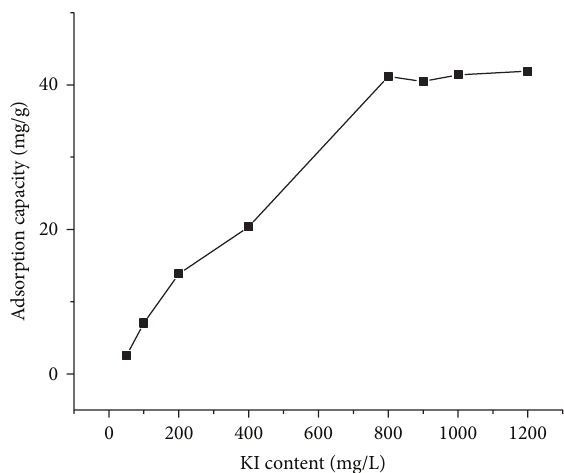
Figure 10: Iodide adsorption capacity of Cu–Mg–Al LDH material as a function of initial iodide